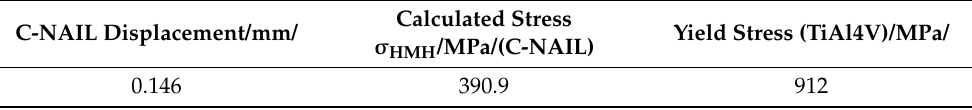
Figure 20. The total displacements on the calcaneal nail C-NAIL in the fragmented heel bone/mm/. Table 1. Results of the displacements and stress on the C-NAIL calcaneal nail. Table 1. Results of the displacements and stress on the C-NAIL calcaneal